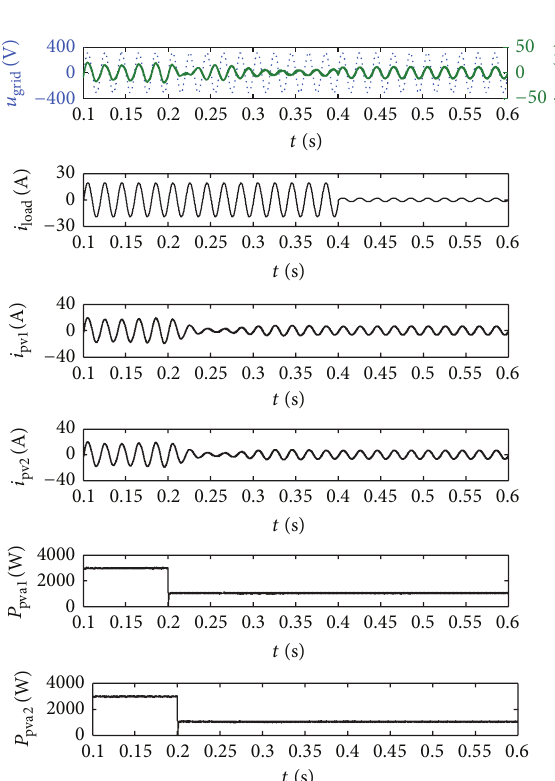
Figure 10: The simulation results of PV array connected to the grid.